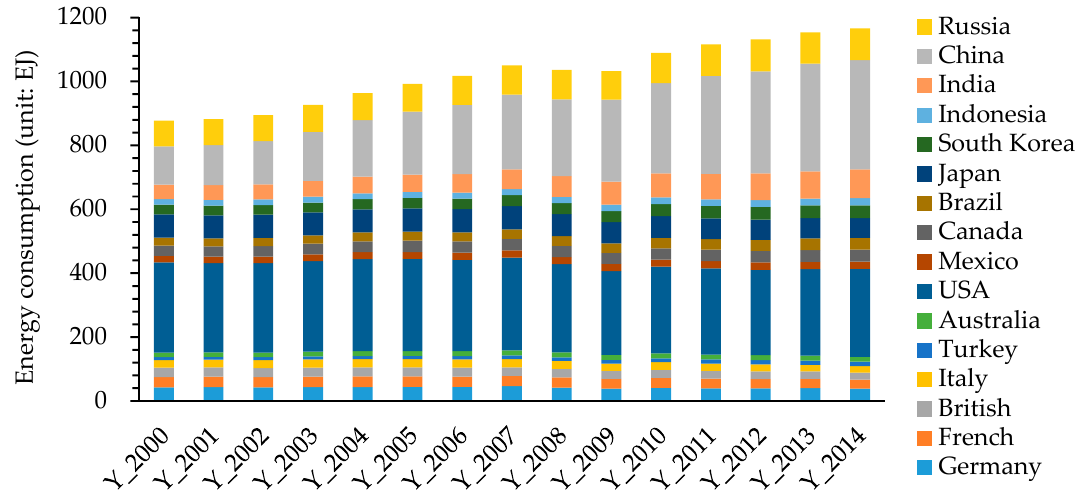
Figure 1. Energy consumption of Group of Twenty (G20) countries from 2000 to 2014.